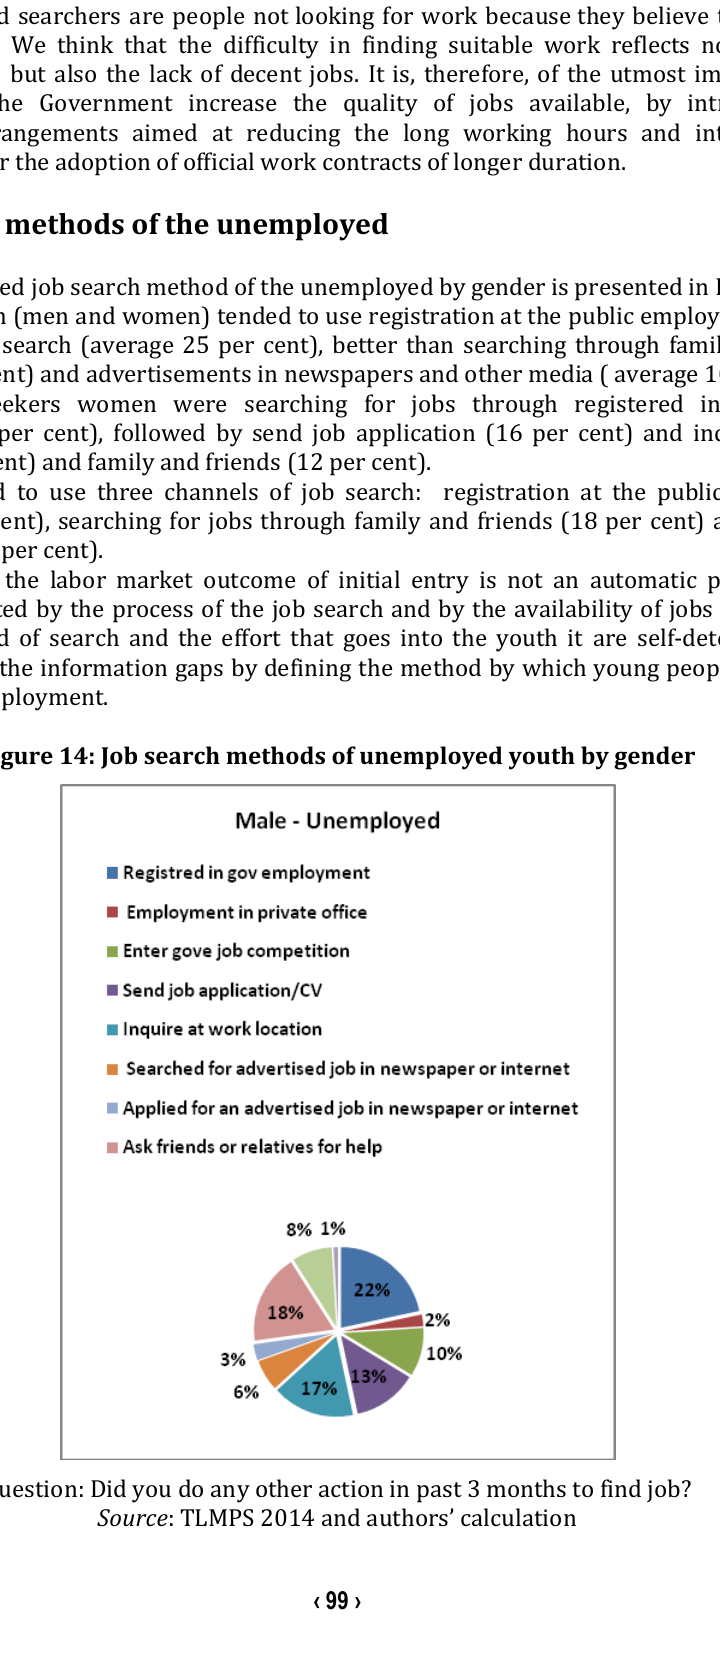
Question: Did you do any other action in past 3 months to find job? Source : TLMPS 2014 and authors’